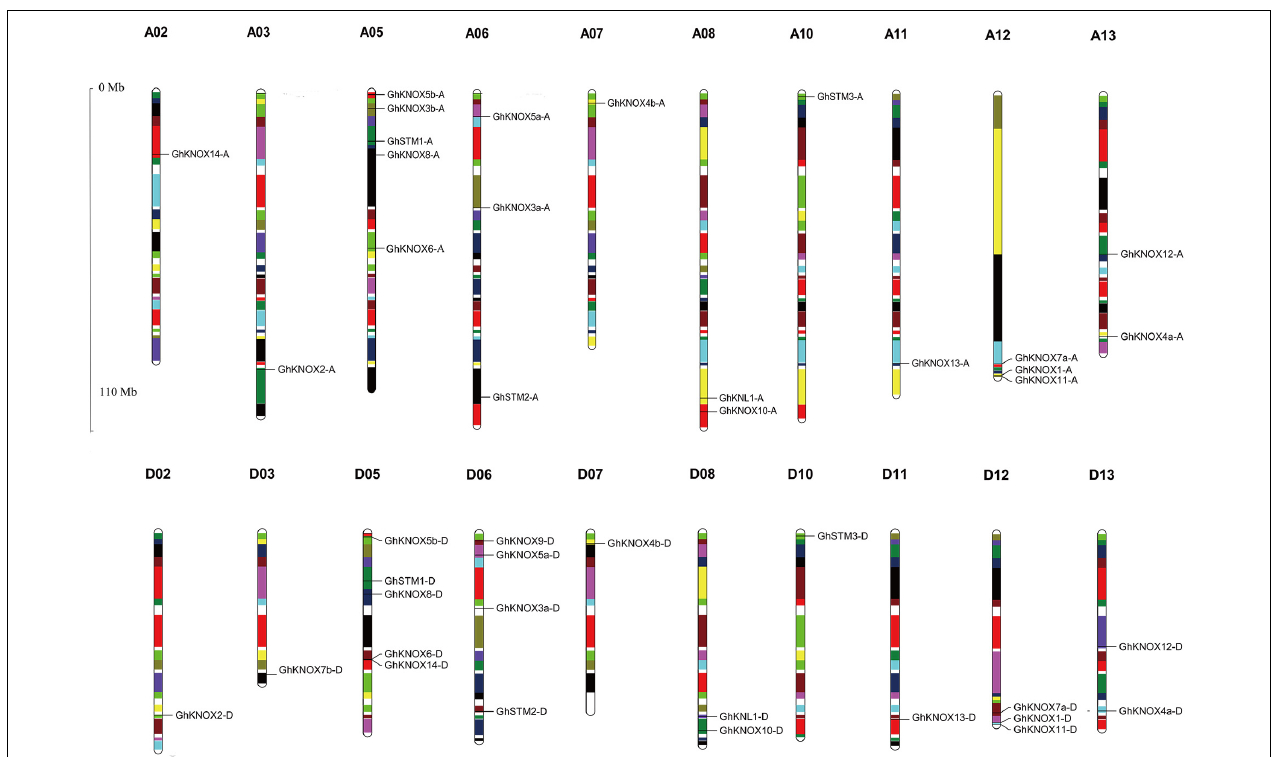
FIGURE 3 | Physical locations of KNOX genes on G. hirsutum chromosomes. The upper and lower panels represent A subgenome chromosomes and D subgenome chromosomes, respectively. The scale is provided in megabases.